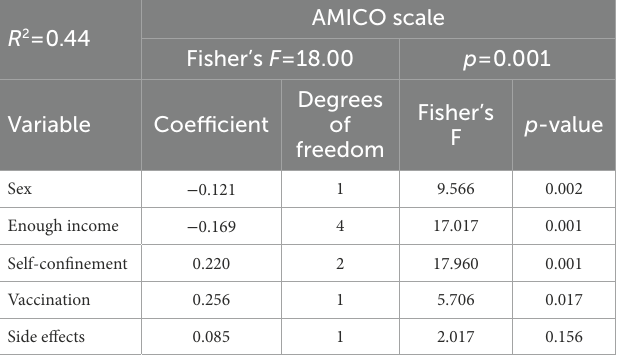
TABLE 2 Model adjustment and significance of the regression analysis.